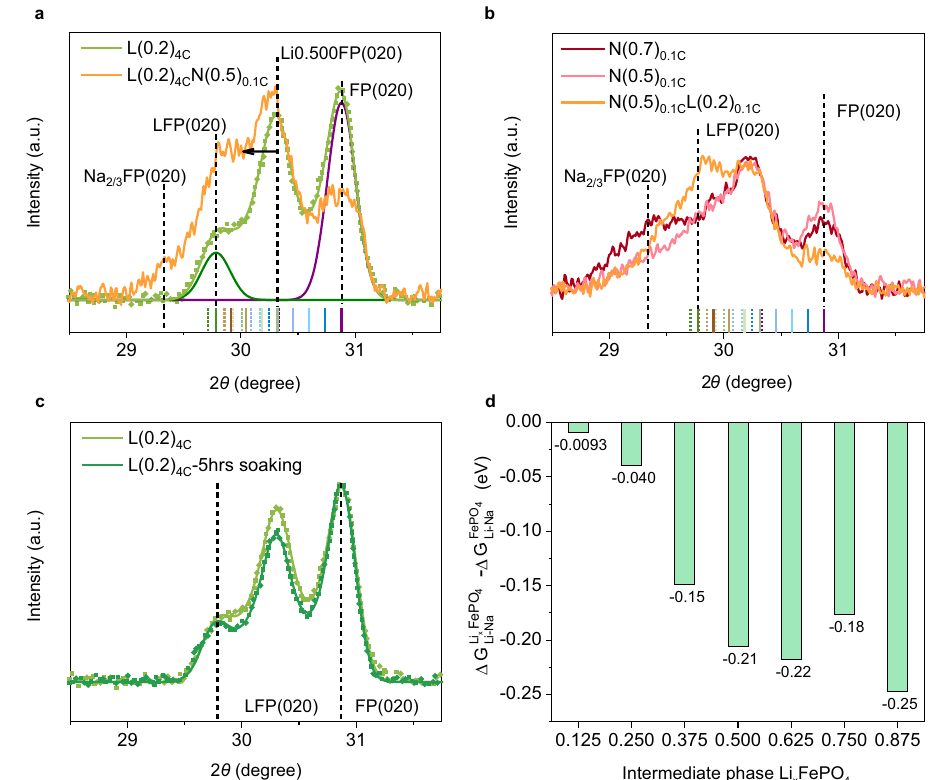
Fig. 4 | Effect of high-Li SS phases in promoting Li competitiveness. a XRD of (dark red), as well as N(0.5) 0.1C electrode before (light red) and after (orange) 20% L(0.2) 4C electrode before(light greendots: raw data;solidlight green line: fi t) and Liinsertion. c XRDofL(0.2) 4C electrodebefore(lightgreen)and after(darkgreen) after(orange:obtainedpattern)50%Nainsertion.Darkgreenandpurplepeaksare 5hsoakingin1MNaCl (aq) (Dottedlines:rawdata;Solidlines: fi t). d DFTcalculation fi ttedLFPandFP(020)peaksforL(0.2) of Li and Na ions intercalation energy difference for each intermediate phase 4C toguidethepeakpositions.Bottombars are the positions of (020) and (211) peaks of nine Li x FePO 4 , x=0/0.125/0.250/ Li x FePO 4 with respect to empty FePO 4 0.375/0.500/0.625/0.750/0.875/1. b Raw XRD patterns of N(0.7) 0.1C electrode